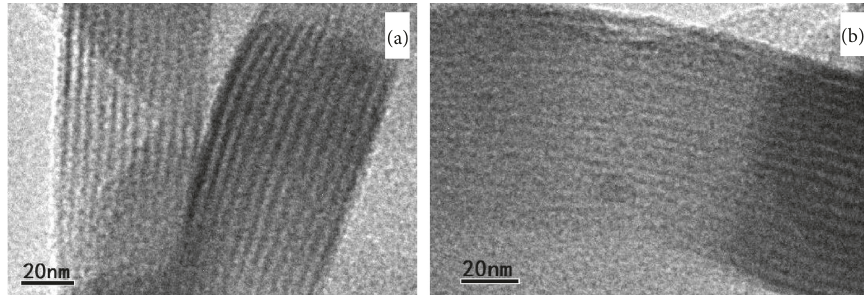
Figure 6: TEM images of the samples (a) MOF-5 and (b) Fe(II)/MOF-5.